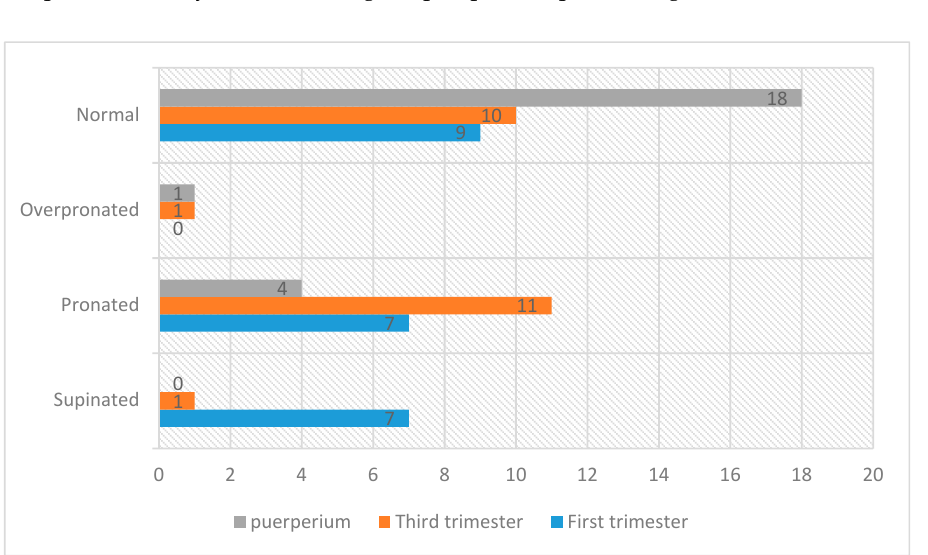
extreme cavus and two flat. Statistically significant differences were obtained between the measurement times for the right foot, comparing the type of cavus and normal foot be- tween the first and third trimesters and between the first trimester and the puerperium (in both cases, p < 0.0001) (Figure 4). Analysis of the percentage of metatarsal width and of the measure complementary to the external arch shows that the plantar arch flattens during pregnancy. Figure 4. Changes in footprint during pregnancy and puerperium.